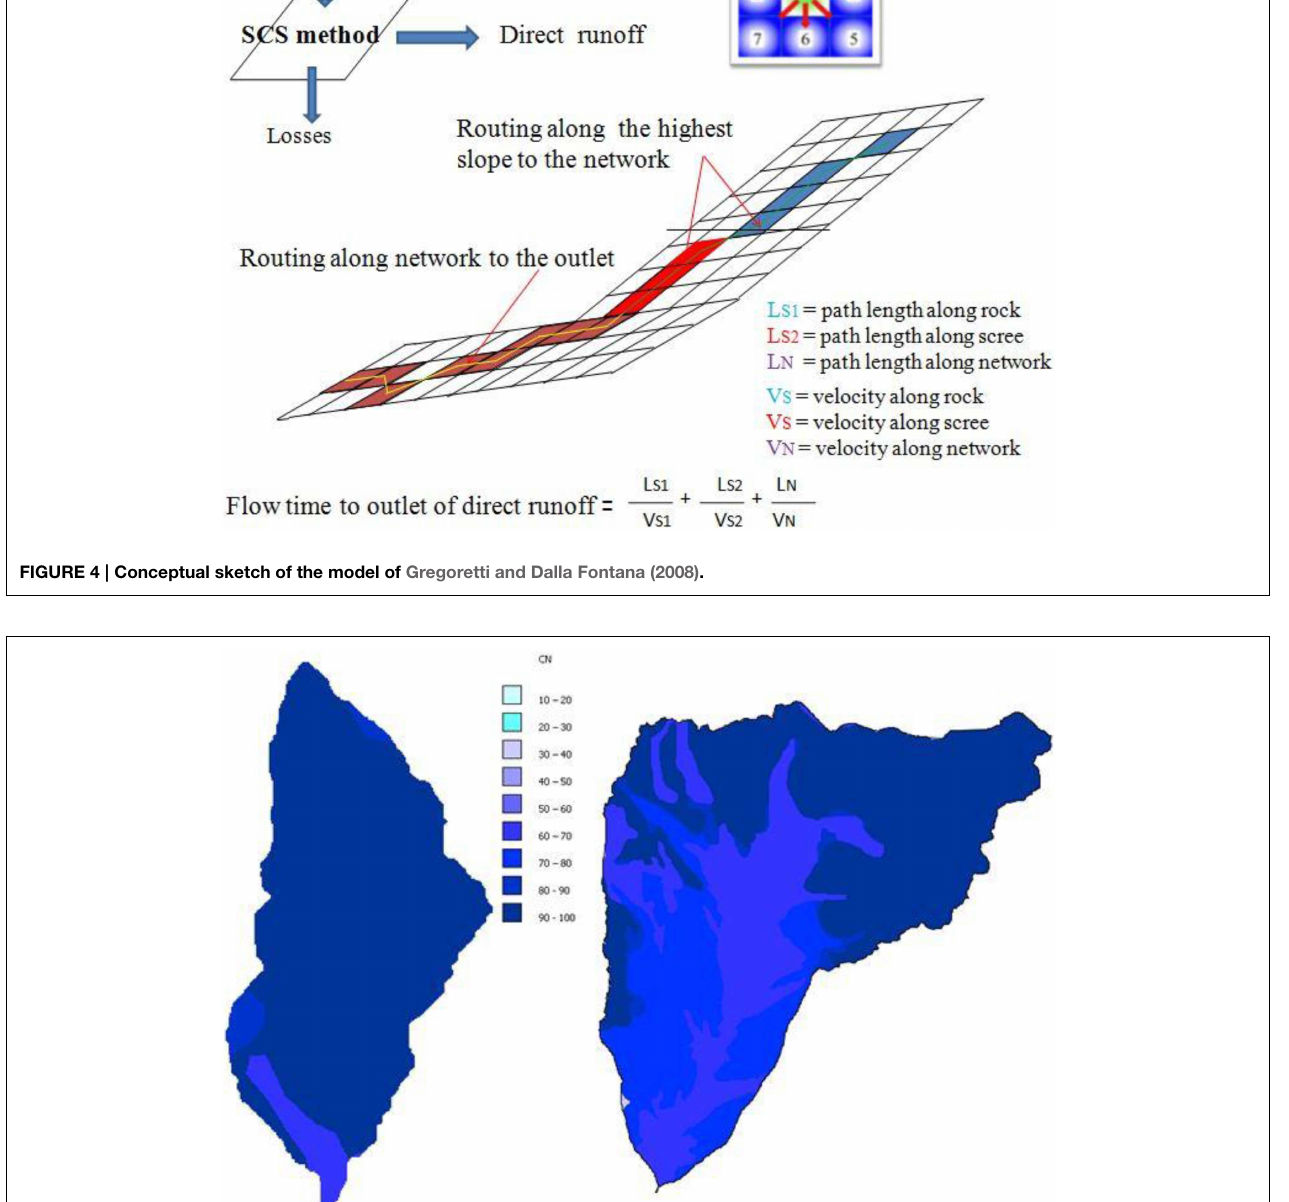
FIGURE 5 | Map of the CN values of the two basins of Dimai (left) and Rovina di Cancia (right).